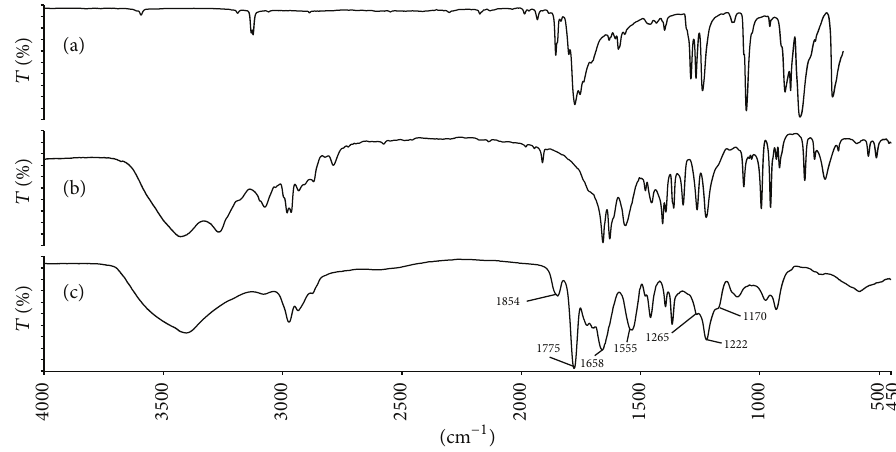
Figure 2: Fragments of FTIR spectra of the MA (a), NTBA (b), and poly(NTBA-co-MA) (c).